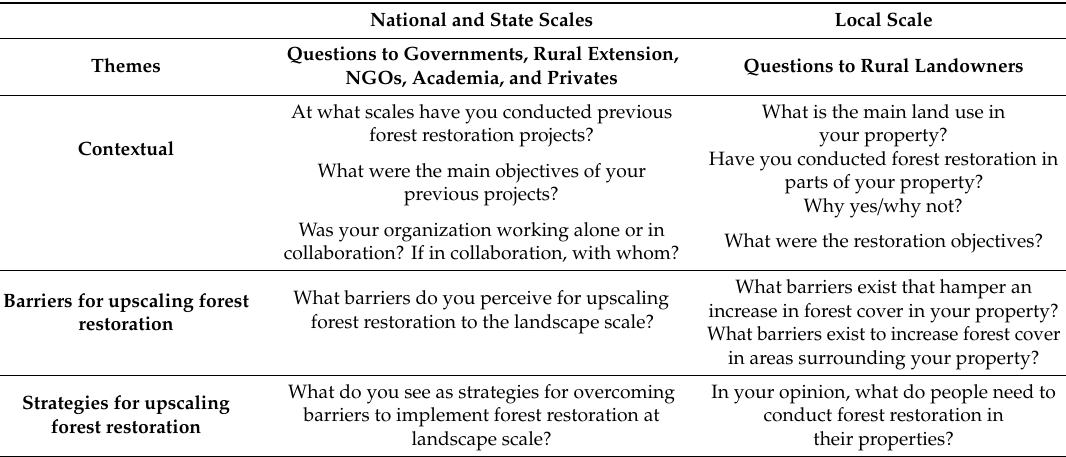
Table 3. Semi-structured interview leading